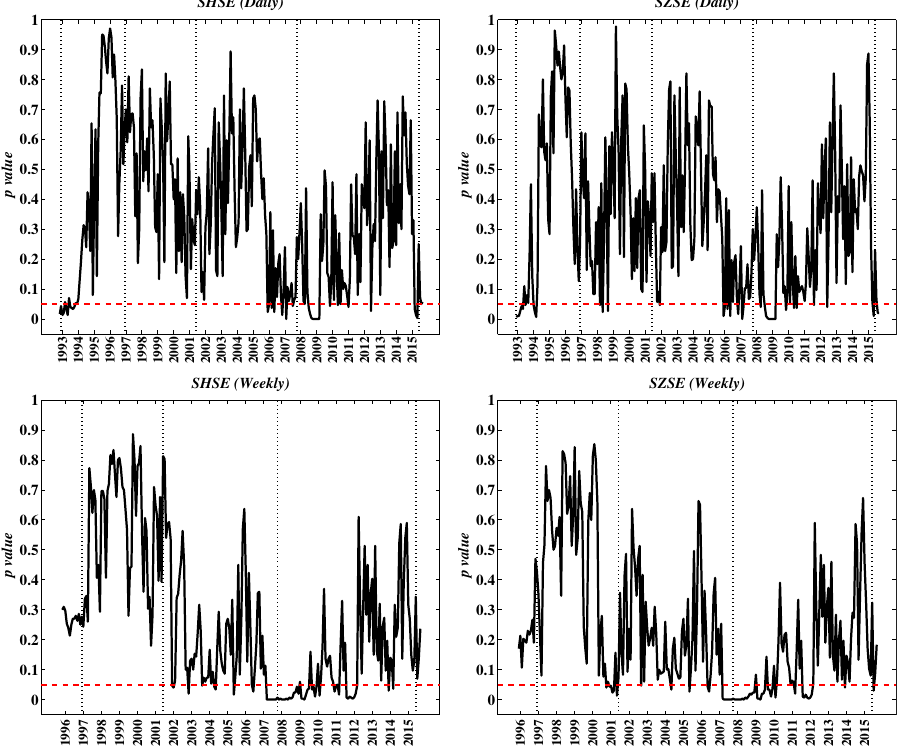
Fig. 2. Time-varying p -values for the GS test statistics of the daily and weekly data in the SHSE and the SZSE from December 1990 to September 2015. The horizontal dashed lines correspond to the 0 : 05 sig- ni¯cance level. The time t represents the time window ½ t (cid:1) 1 ; t (cid:2) for daily data, and ½ t (cid:1) 4 ; t (cid:2) for weekly data. The return time series exhibit statistically signi¯cant nonlinear dependence if the p -value falls down beneath the dashed line corresponding to the signi¯cance level of